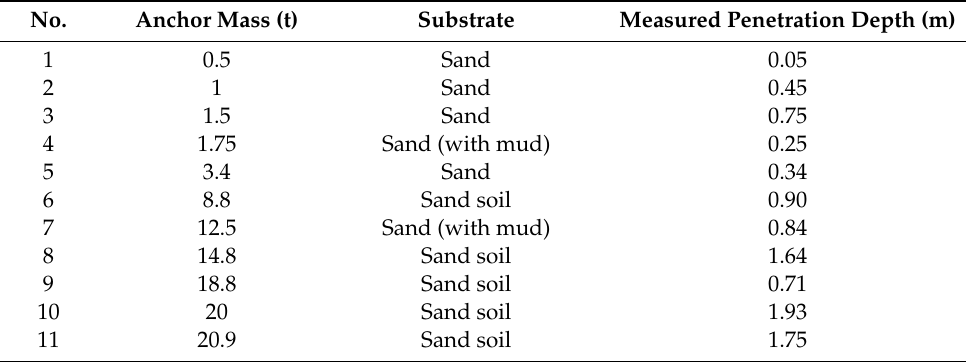
Table 4. Penetration depth in sand substrate from anchoring experiments.